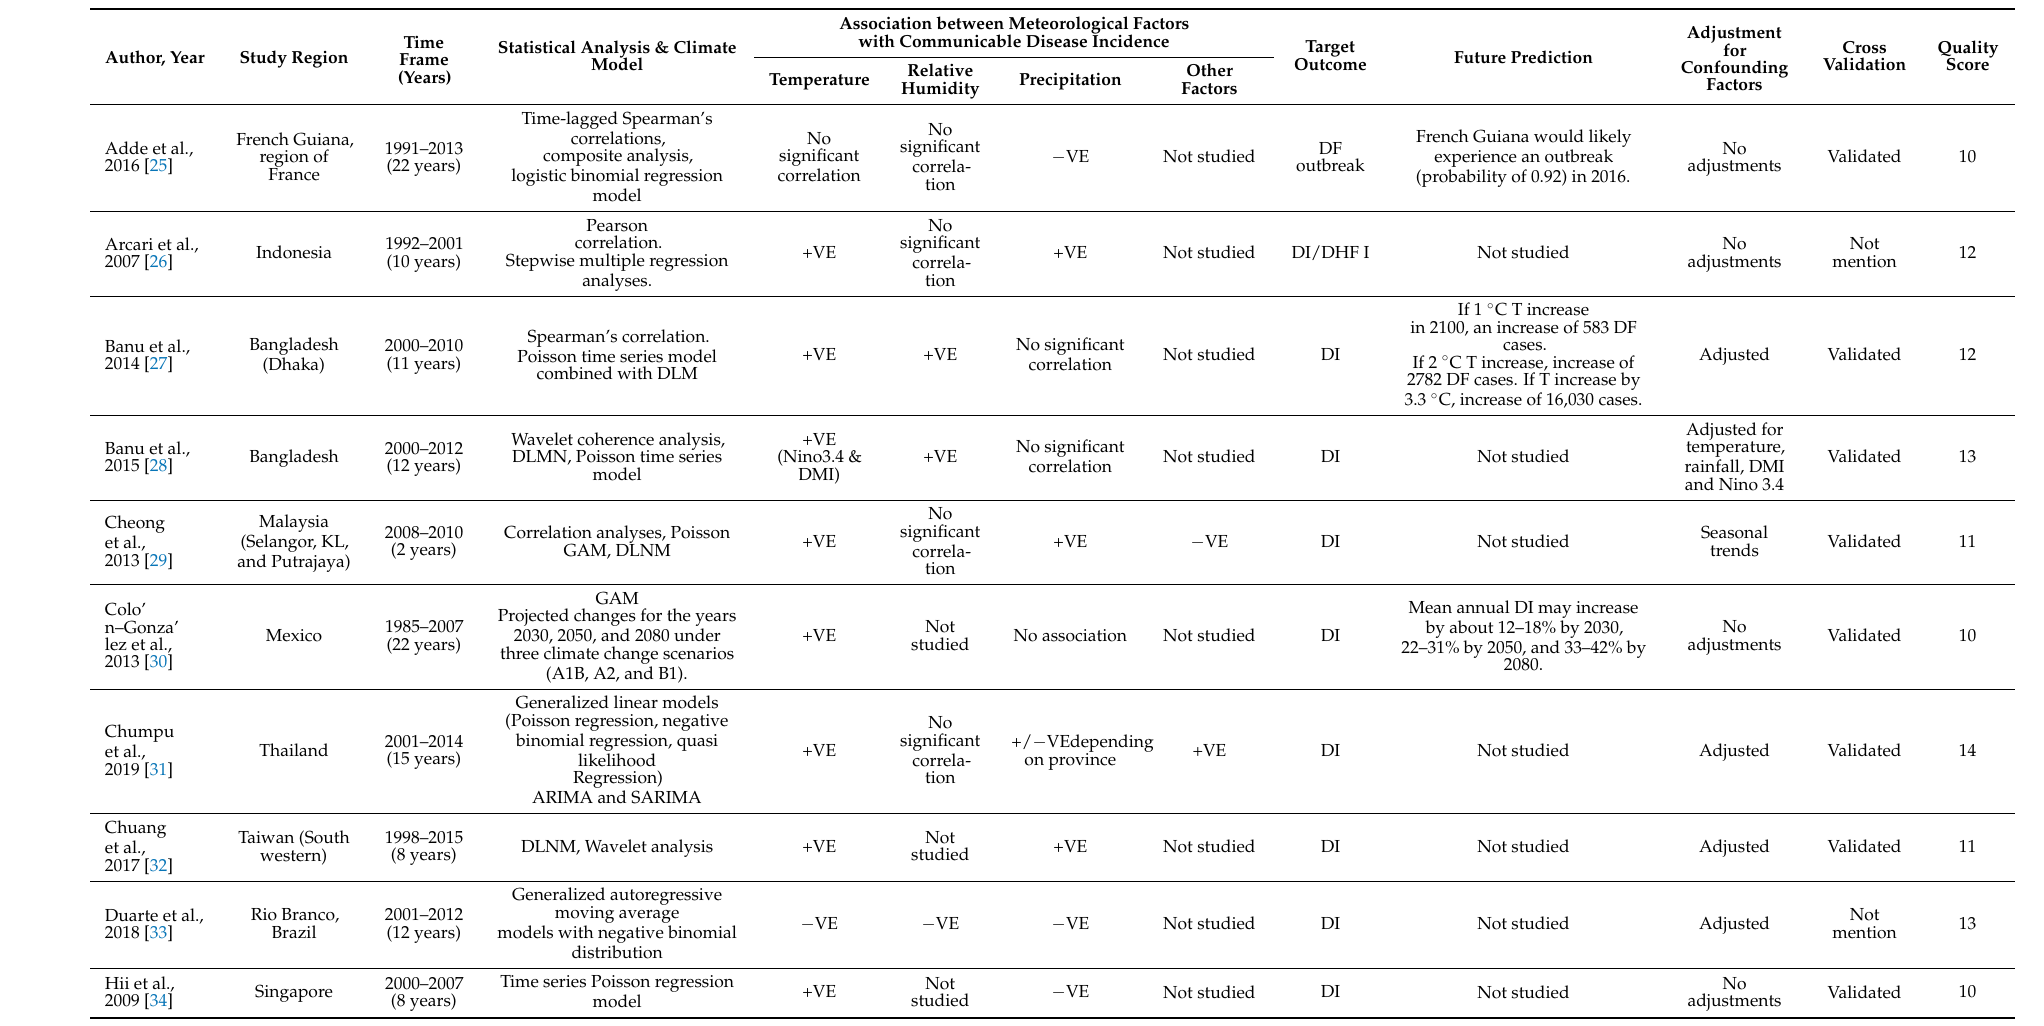
Table 2. Characteristics of all the included